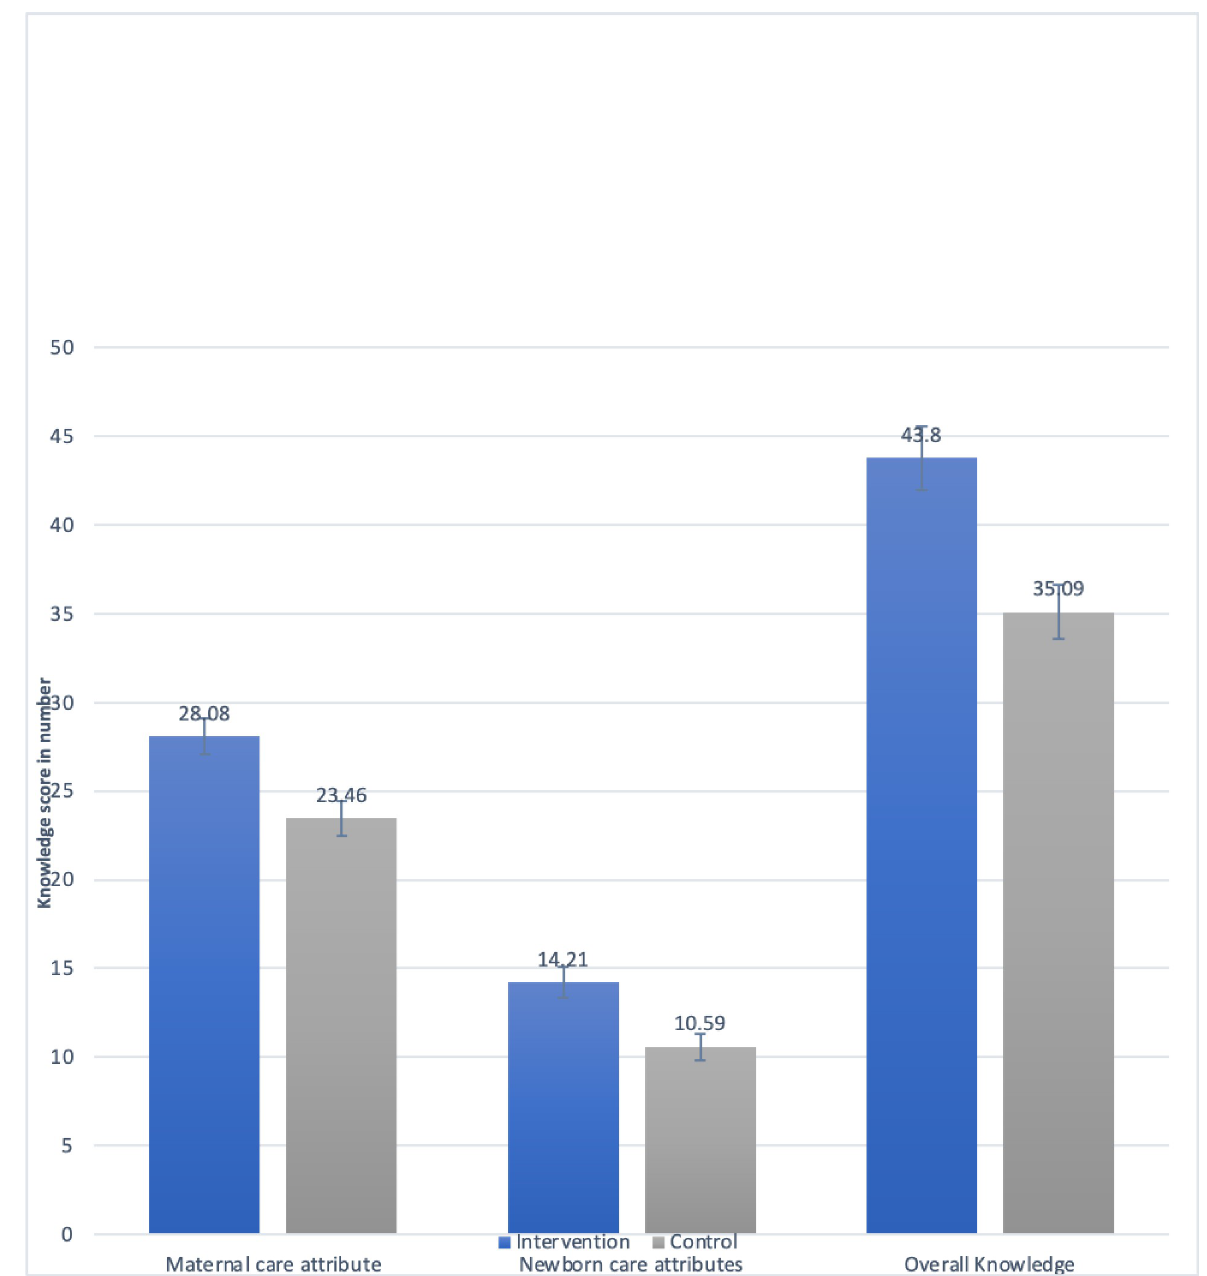
Fig 3. Bar graph showing PNC knowledge score of intervention and control group at end-line.